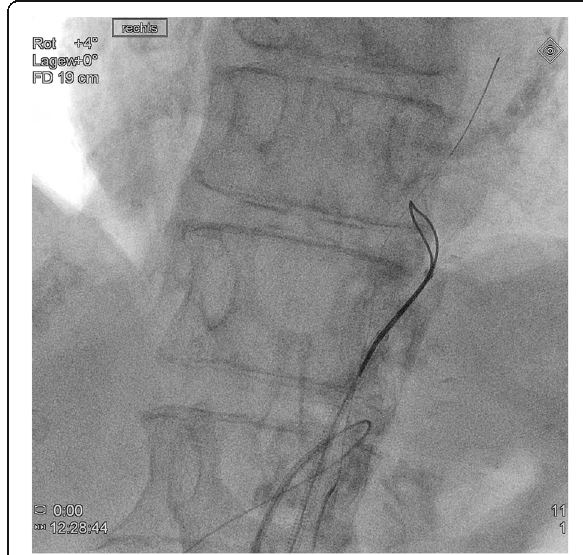
Fig. 3 The free end of the 0.014-in. guide wire was captured with a loop catheter and externalized through the sheath in the left common femoral